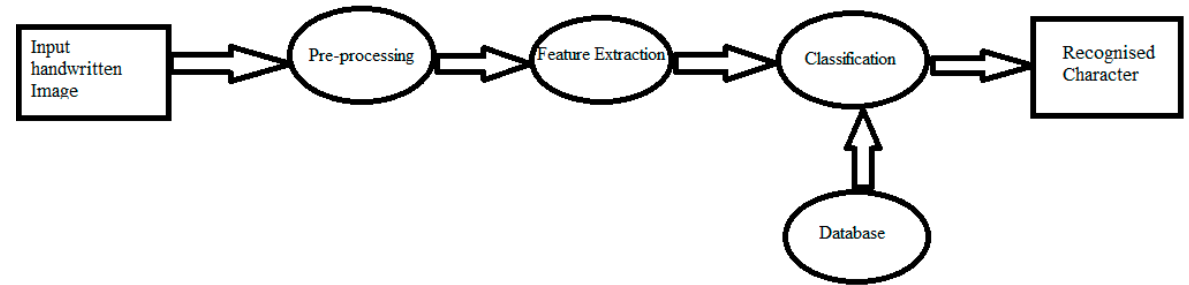
Figure 1. Representation of a common handwritten character recognition (HCR) system.